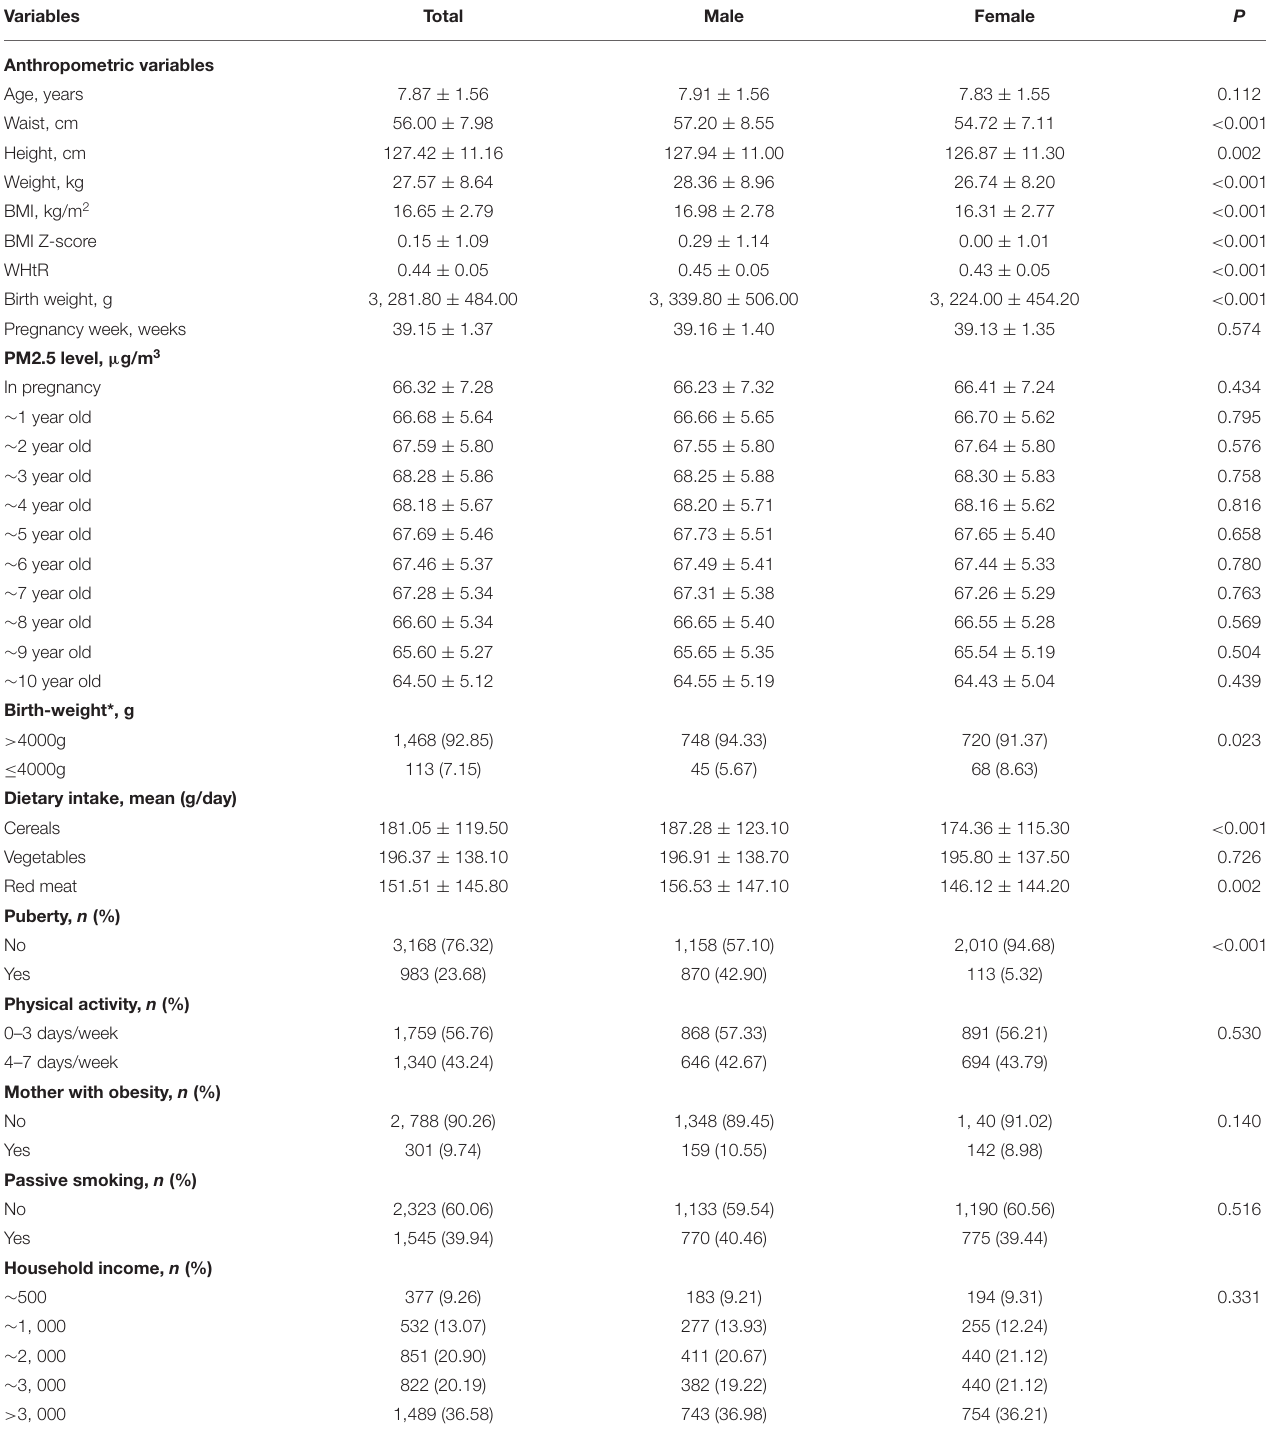
TABLE 1 | The characteristics of participants at baseline.